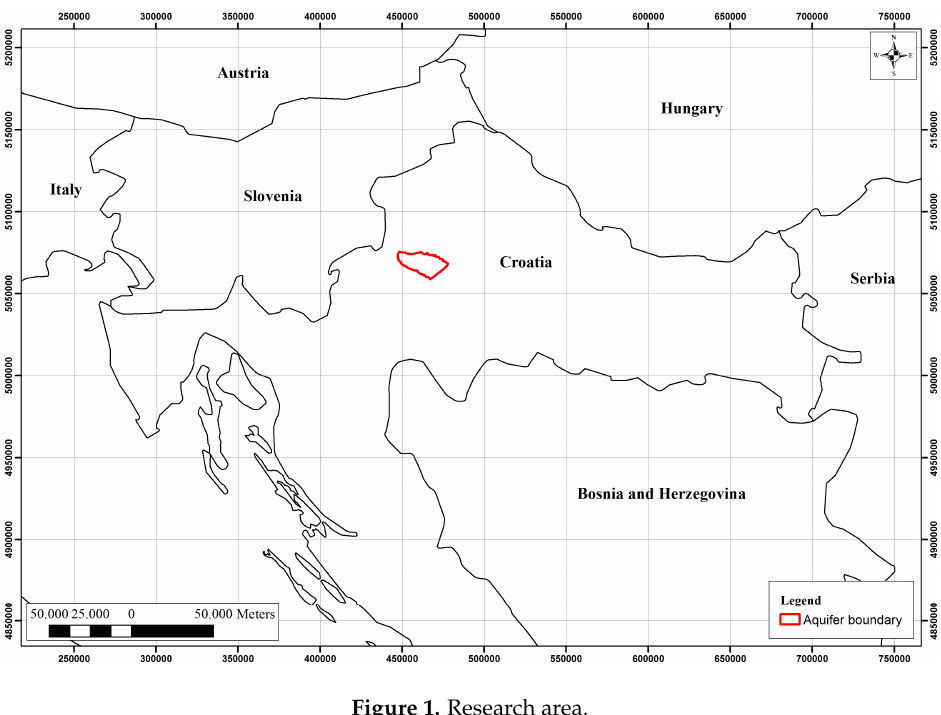
Figure 1. Research area.